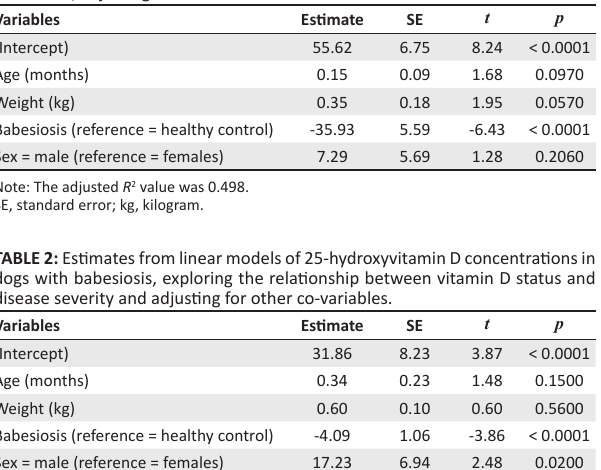
FIGURE 1: Serum 25-hydroxyvitamin D concentrations in dogs with babesia and healthy dogs. The black line indicates the mean concentration in each group.